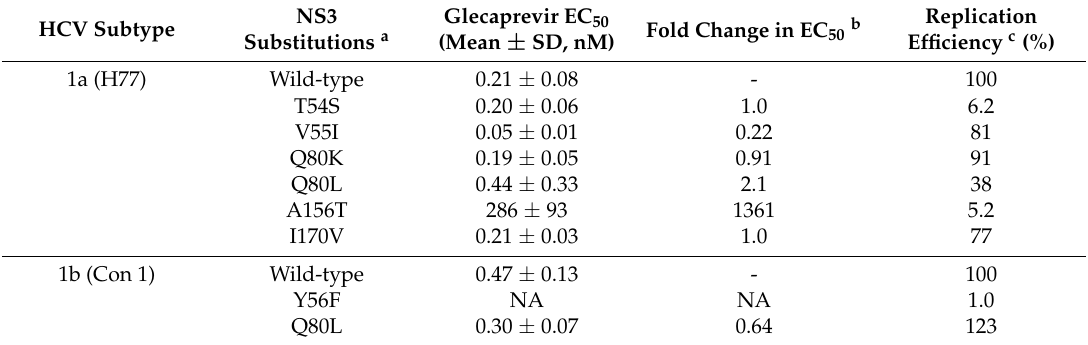
Table 4. Susceptibility of baseline or treatment-emergent NS3 substitutions to